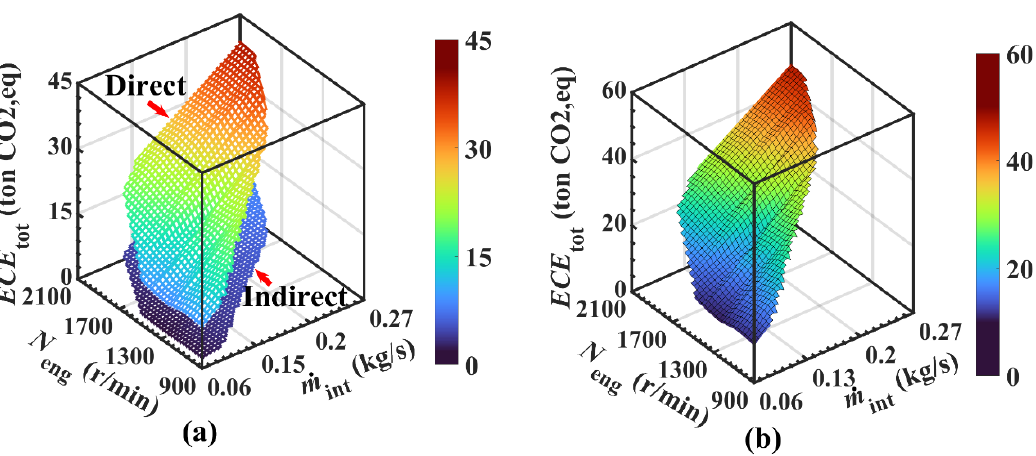
Figure 17. ECE of HT cycle, LT cycle and system under variable working conditions. (a) Direct ECE and indirect ECE. (b) System ECE.